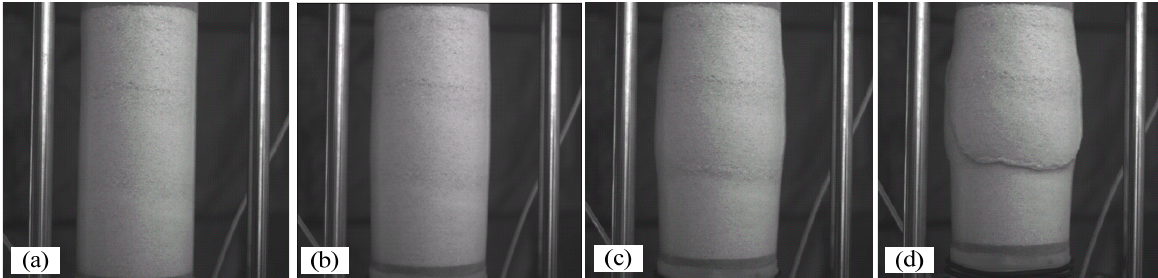
Figure 8 . Photographic images of test 120904c at 0.2% of axial strain ( a ), 3.6% of axial strain ( b ), 7% of axial strain ( c ), and 12% of axial strain ( d